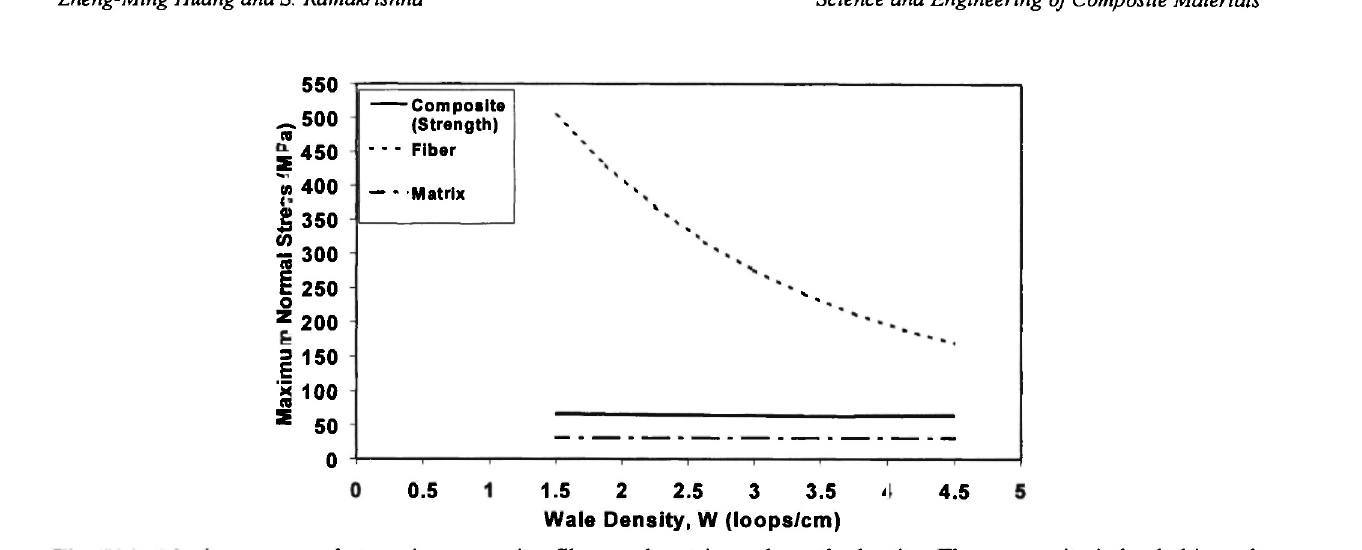
Fig. 7 (a): Maximum normal stress in composite, fiber, and matrix vs the wale density. The composite is loaded in wale direction.The geometric parameters used are: p f =2. 54g/cm 3 , aH).0445cm, K=0.45, iy=177.8(Tex), C=2.5loop/cm and /=0.06cm.